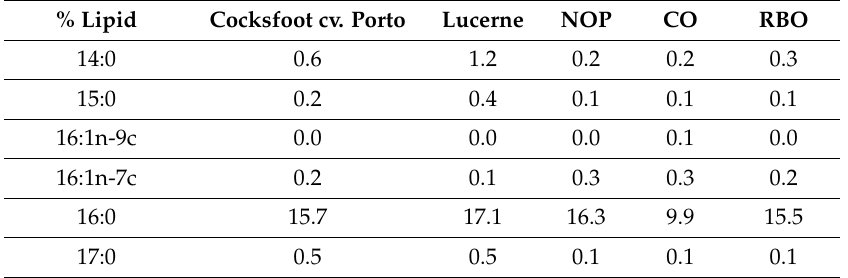
Table 2. Fatty acid composition (as % total fatty acids) of supplementary feeds and